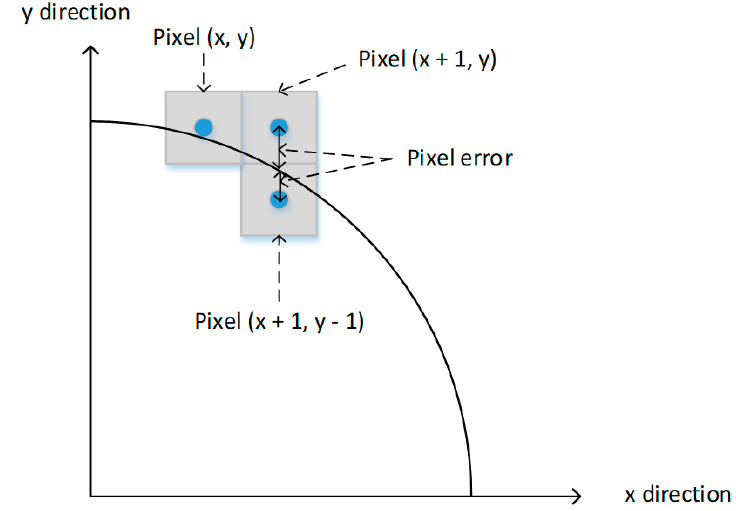
Figure 4. Illustration of pixel location generation using the Bresenham circle algorithm (BCA) method.